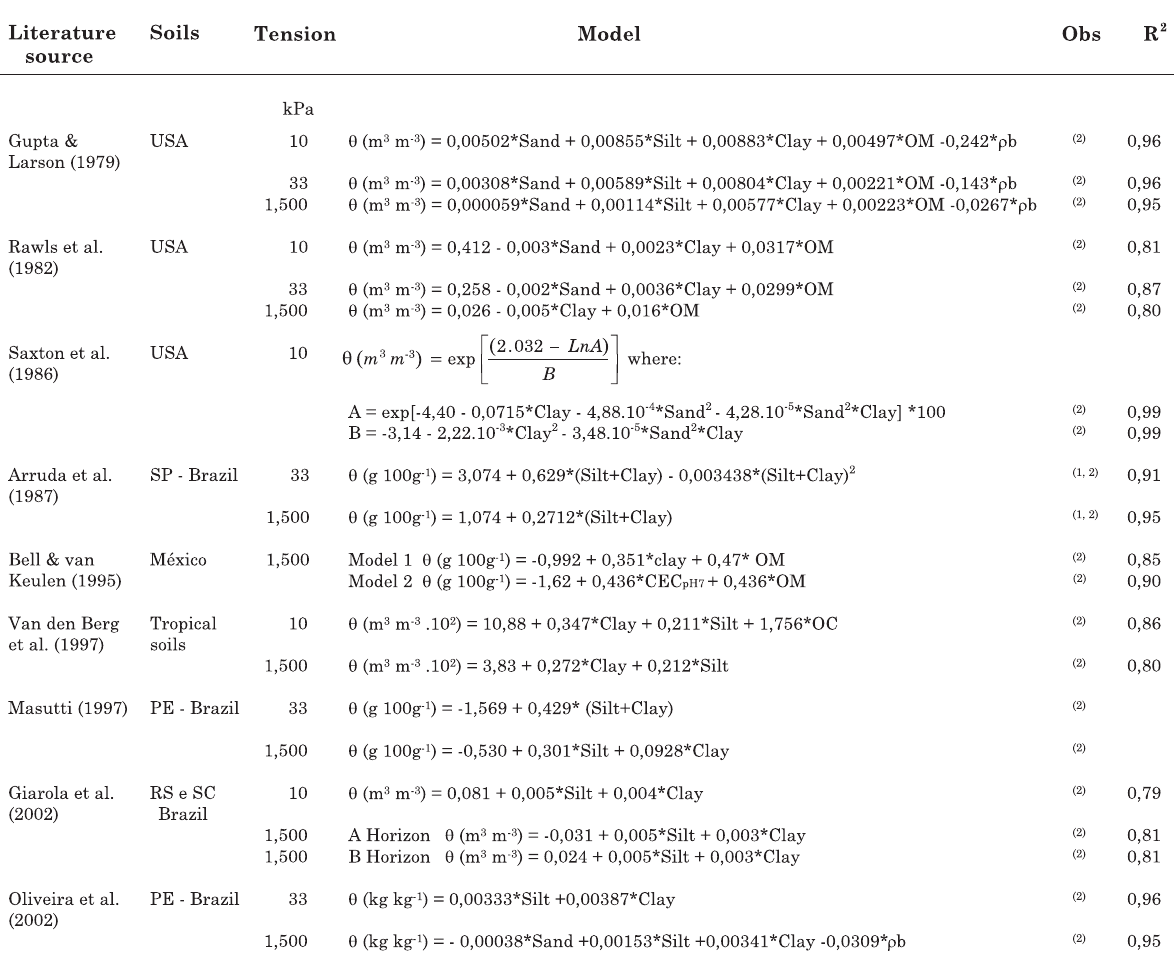
Table 1. Equations from the literature used to estimate water content of the soils from the database that gave origin to the proposed